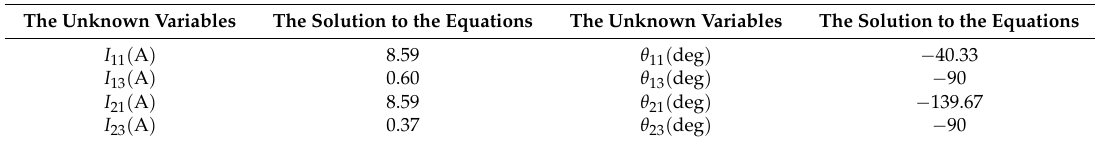
Table 8. The optimum solutions to the fault-tolerant current under single-phase open-circuit fault type in inner motor.